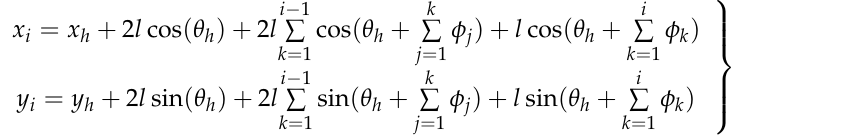
Figure 2. Serpenoid curve.